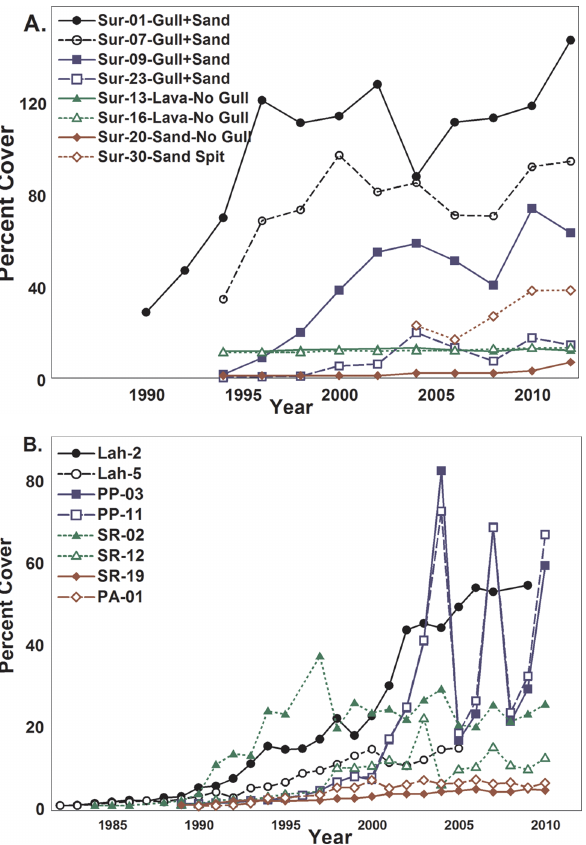
Fig. 13. Percentage cover on selected plots. (A) Surtsey; (B) Mount St.